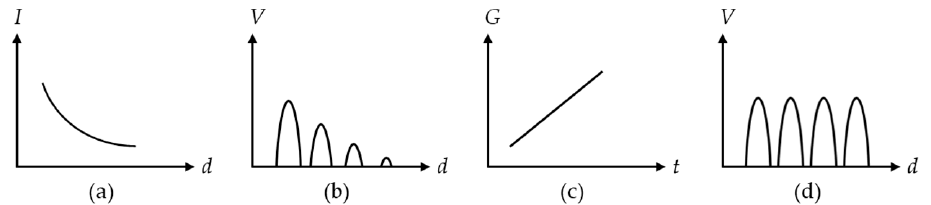
Figure 23. Gain compensation ( a ) Sound intensity varies with distance; ( b ) The relationship between received signal intensity and distance; ( c ) Compensation coefficient; ( d ) The relationship between received signal intensity and distance after compensation.